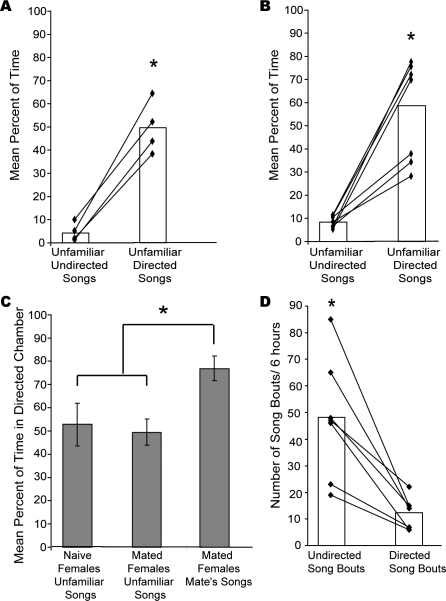
Mated and Naive Females Prefer Unfamiliar Directed Songs to Unfamiliar Undirected Songs(A) Mean percent of time that mated females spent in the unfamiliar undirected and directed song chambers for the four behavior tests on which females displayed a preference. Females significantly preferred unfamiliar directed to undirected songs (*p < 0.05).(B) Mean percent of time that naive females spent in the unfamiliar undirected and directed song chambers. Seven females showed significant preferences for at least one of the stimuli. Because some females responded to stimuli from more than one male, diamonds represent the average response for each female. Naive females significantly preferred directed song to undirected song (*p < 0.05).(C) Mated females tested on their mate's songs spent significantly more time in the directed song chamber (*p < 0.05) than did naive or mated females tested on unfamiliar songs.(D) Number of undirected and directed song bouts produced over a 6-h period by males housed with their mates. While directed song bouts tended to be longer and accompanied by additional courtship behaviors and copulation attempts, males sang significantly more undirected song bouts (*p < 0.05).